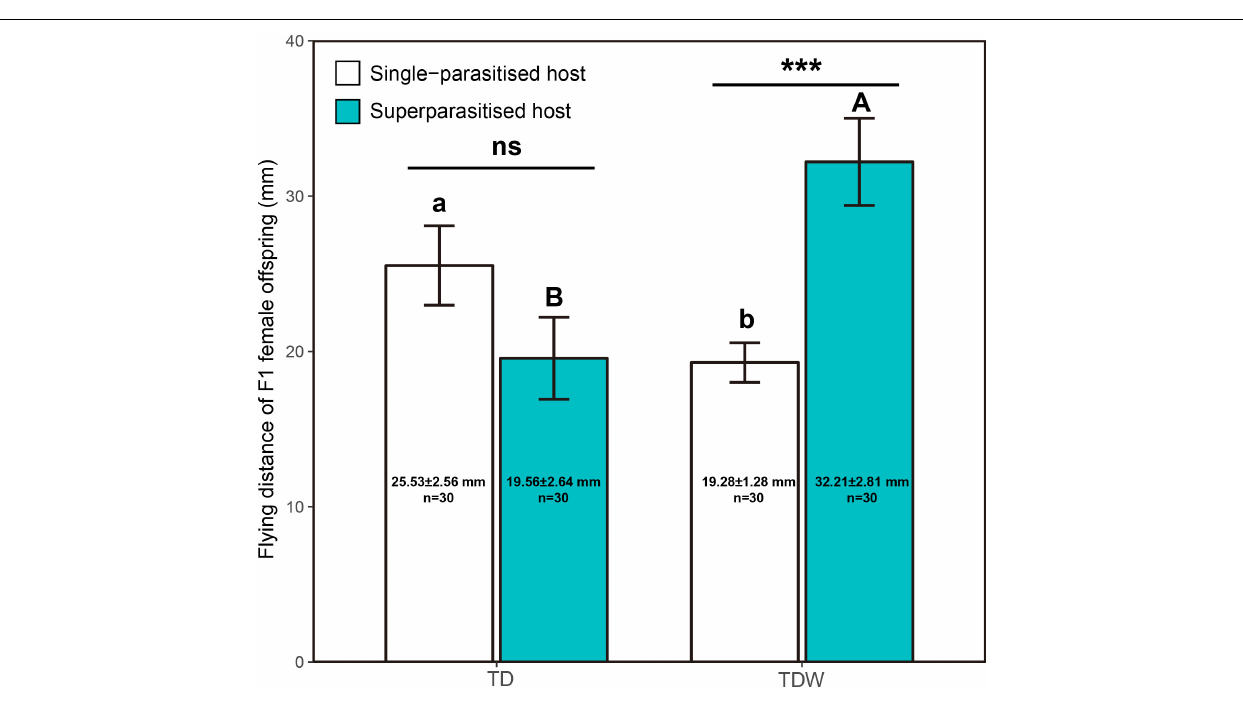
FIGURE 4 | Flying distance of TDW or TD F1 female offspring developed from superparasitised or single-parasitised hosts. Bars indicate Means. Error bars indicate the interval of Mean ± Standard Error. The different uppercase letters indicate significant difference between TD ( n = 30) and TDW ( n = 30) in superparasitised hosts. The different lowercase letters indicate significant difference between TD ( n = 30) and TDW ( n = 30) in single-parasitised hosts. “ns” or “***” indicates non-significant difference or significant difference at P < 0.001, respectively, between superparasitised hosts and single-parasitised hosts. Texts labeled on the bars indicate sample size and values of Mean ± Standard